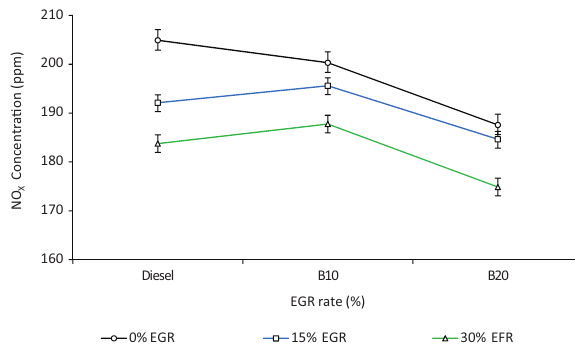
Figure 7. Effect of oxygenated fuels and different EGR rates on the NO X emissions concentration under 1800 rpm